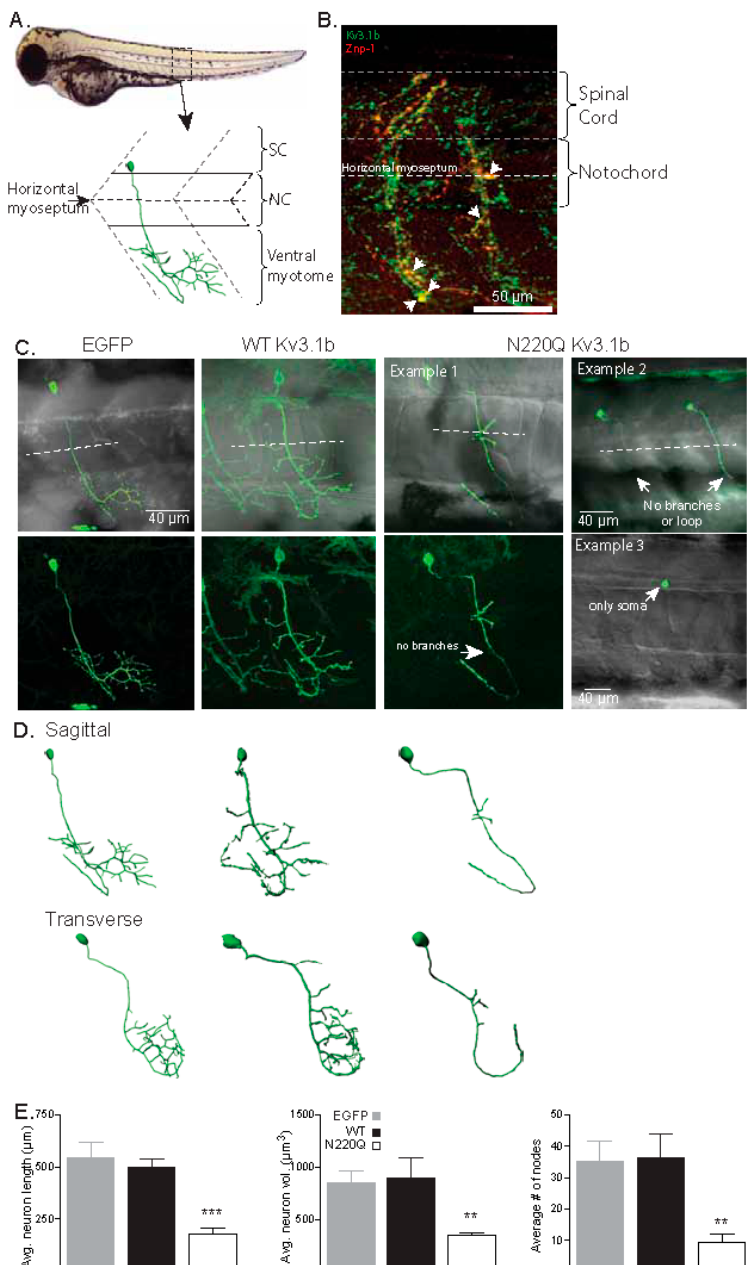
Figure 1. N-Glycosylation occupancy of Kv3.1b alters its spatial arrangement in motor neurons. ( A ) Schematic of a spinal hemi-segment illustrating the morphological innervation of the caudal primary motor neuron (CaP) of the ventral musculature. ( B ) A confocal projection (~40 µ m stack) of one spinal hemi-segment illustrating the IHC co-staining of the Kv3.1b channel (Alexa Fluor 488, green) and Znp-1 (Alexa Fluor 555, red) in a CaP motor neuron. Arrowheads denote over-lapping expression of Kv3.1b and Znp-1. ( C ) Confocal projections of CaP neurons expressing EGFP, WT and N220Q Kv3.1b proteins. The bottom row shows confocal images, and top row images are overlaid with transmitted images to show the horizontal myoseptum (dashed line). ( D ) 3D digital rendering of the reconstructed neurons of images in ( C ) shown in both sagittal and transverse orientation. ( E ) Average axonal length, neuron axonal volume and number of nodes of CaP neurons expressing EGFP ( n = 12), WT ( n = 10) and N220Q ( n = 11) Kv3.1b proteins. Graphs denote mean ± SEM and were compared by one-way ANOVA followed by Kruskal-Wallis adjustment (** p < 0.0005, *** p < 0.0001). See also Movies Figures